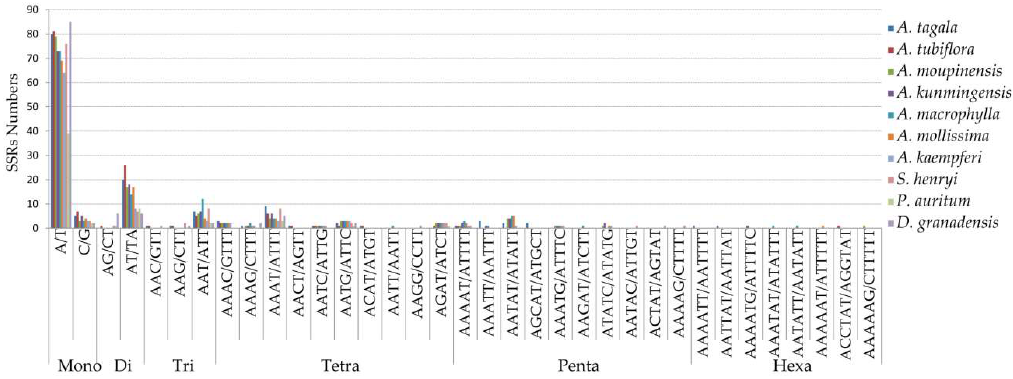
Figure 6. Frequency of simple sequence repeats (SSRs) in the ten cp genomes.